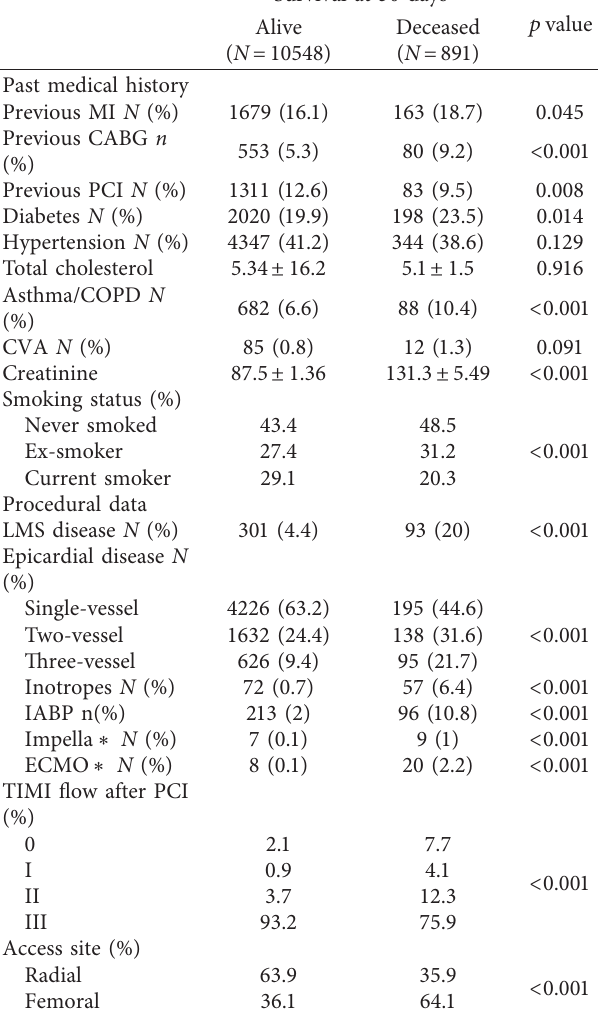
Table 5: Past medical history and procedural data grouped by vital status at 30 days.